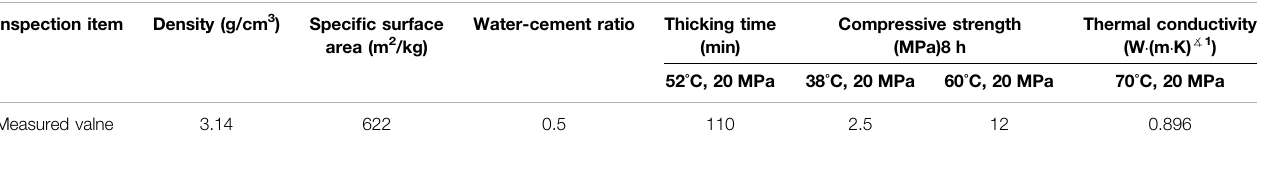
TABLE 2 | Physical properties of Class G